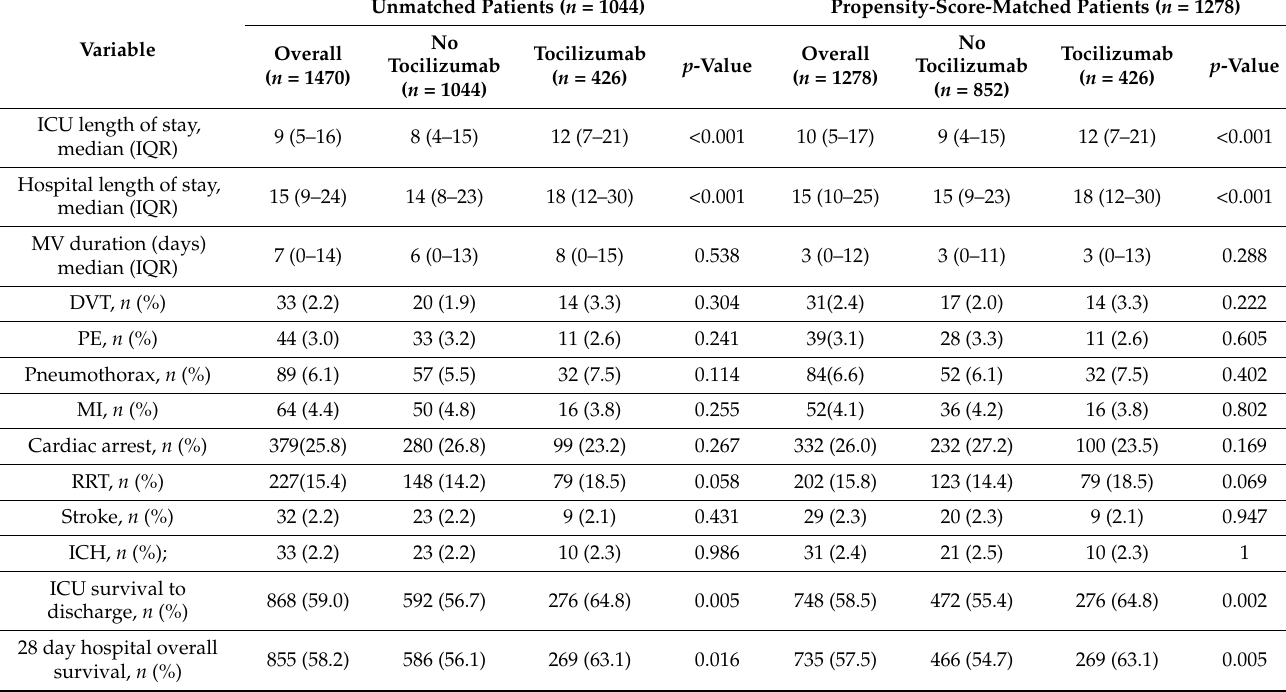
Table 2. Complications and patient outcomes.